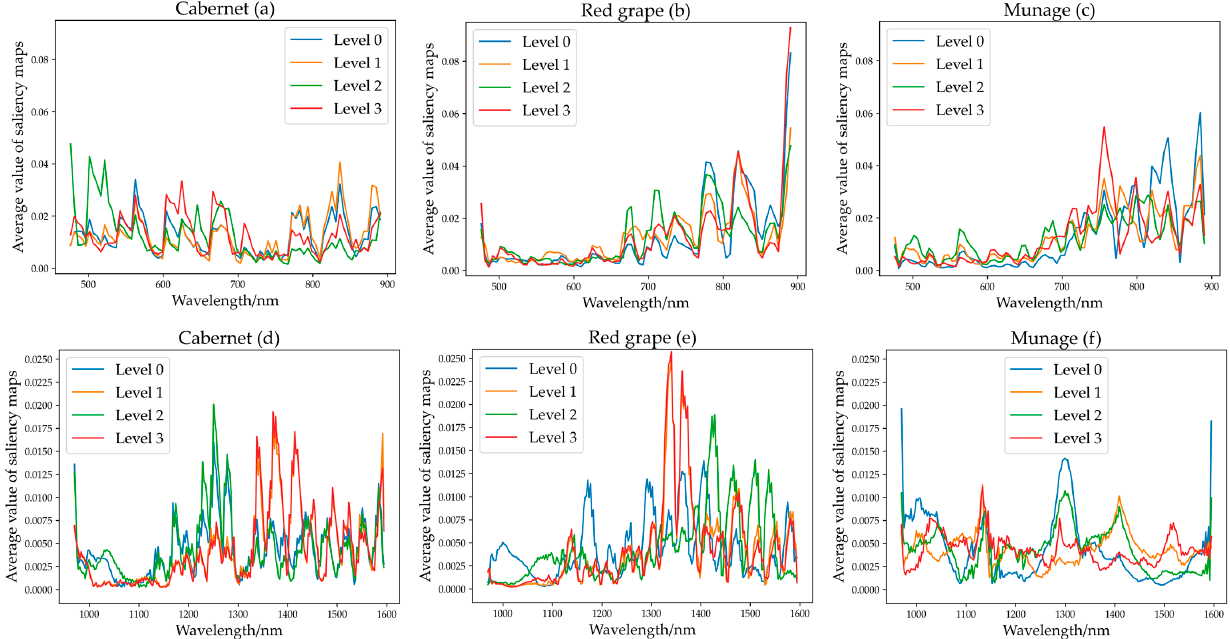
Figure 6. ( a – c ) Mean average value of saliency map of CNN for Cabernet, Red grape, and Munage for Vis-NIR spectra. ( d – f ) Mean of CNN for Cabernet, Red grape, and Munage for NIR spectra. For NIR spectra, the contributions of the first three PCs of Cabernet were 56.3%, 22.3%, 17.5%; those of Red grape were 57.4%, 31.3%, 6.6%; and those of Munage were 70.8%, 20.0%, 4.9%. The cumulative contributions of the first three PCs were 96.1%, 95.3%, and 95.7%, respectively, which also explained most of the variance information. Regard- ing the sample distribution, the overall clustering effect was slightly better than that of the Vis-NIR. For Cabernet, in Figure S1j–l, two major aggregating regions were shown (Level 0 and Level 2, Level 1 and Level 3), which is consistent with the phenomenon in Figure 5b. Therefore, the result comparatively illustrates the feasibility of the identification of four levels of pesticide residues in the range of NIR spectra. In general, PCA visualizes sample distribution and provides the feasibility of classi- fication, but it is not easy to directly distinguish the four levels of pesticide residues. Therefore, it is necessary to find other multivariate analysis methods for further research. 3.3. Classification Models Three machine learning algorithms (SVM, LR, and RF) and two deep learning (CNN and ResNet) algorithms were conducted to analyze spectral data in this stage. The results are shown in Table 4 below.